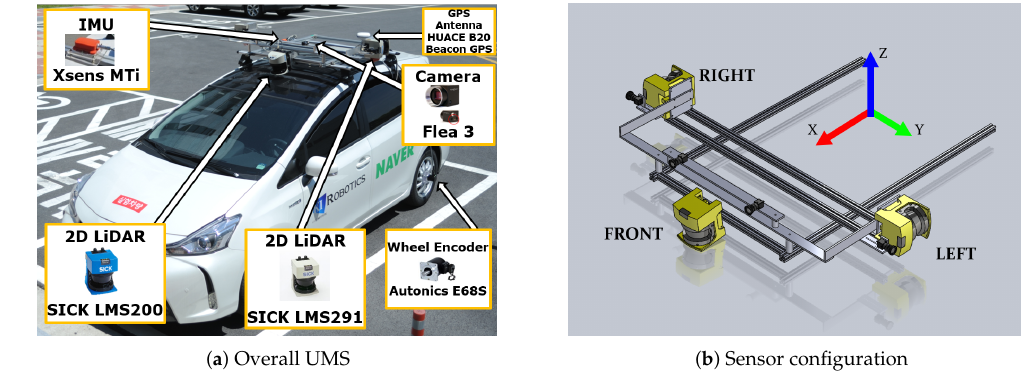
Figure 1. Sensor system description. Our sensor suite includes two 2D LiDARs, four cameras, a GPS, two wheel encoders, an IMU, and an altimeter. Note that the front LiDAR in ( b ) is only for moving object detection, and thus excluded in Simultaneous Localization and Mapping (SLAM) framework.